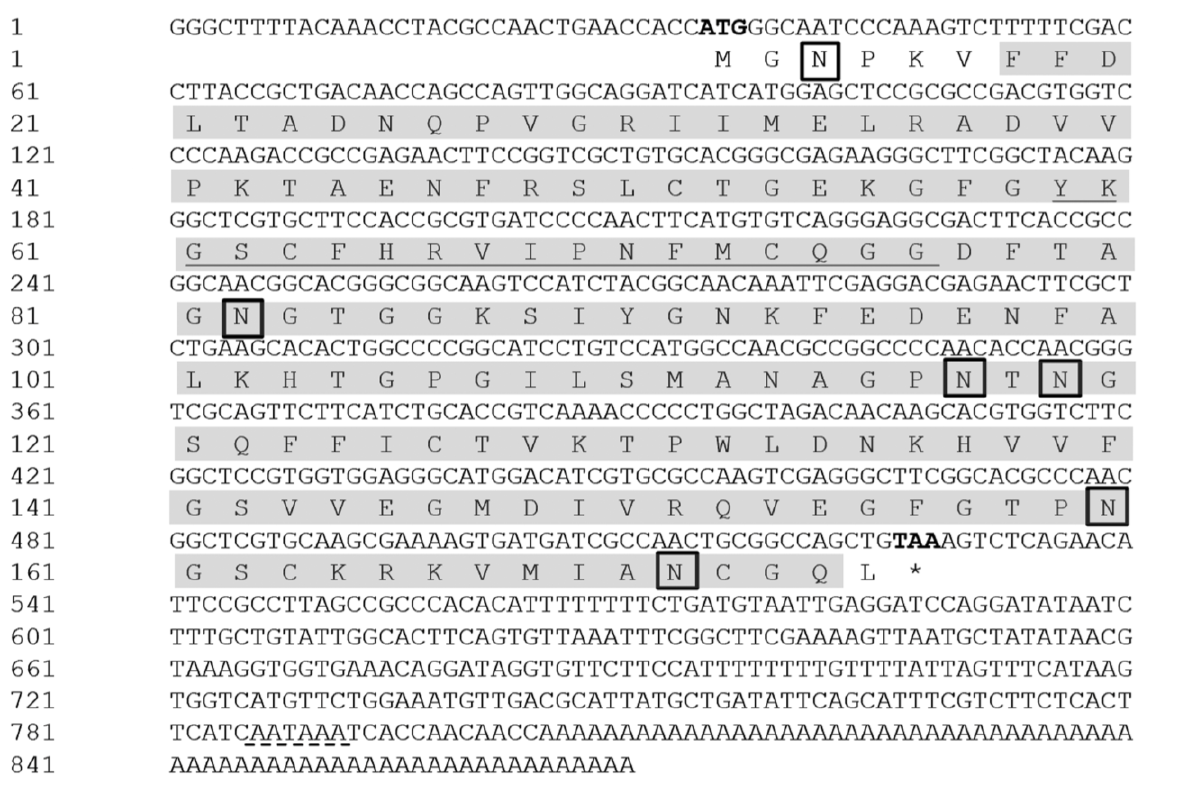
Fig. 1 Nucleotide and deduced amino acid sequence of Fc CypA. The nucleotides and amino acids were numbered along the left margin. The function domain was in shade. The start and codon was marked in bold, the asterisk indicated the stop codon and the classical polyadenylation signal in the 3’-UTR is dotted underlined. The Cyp-type peptidylprolyl cis-transisomerase signature was indicated in underline. The black boxes are showing the glycosylation sites.The amino acid sequence of Fc CypA has been submitted to GenBank with the accession number